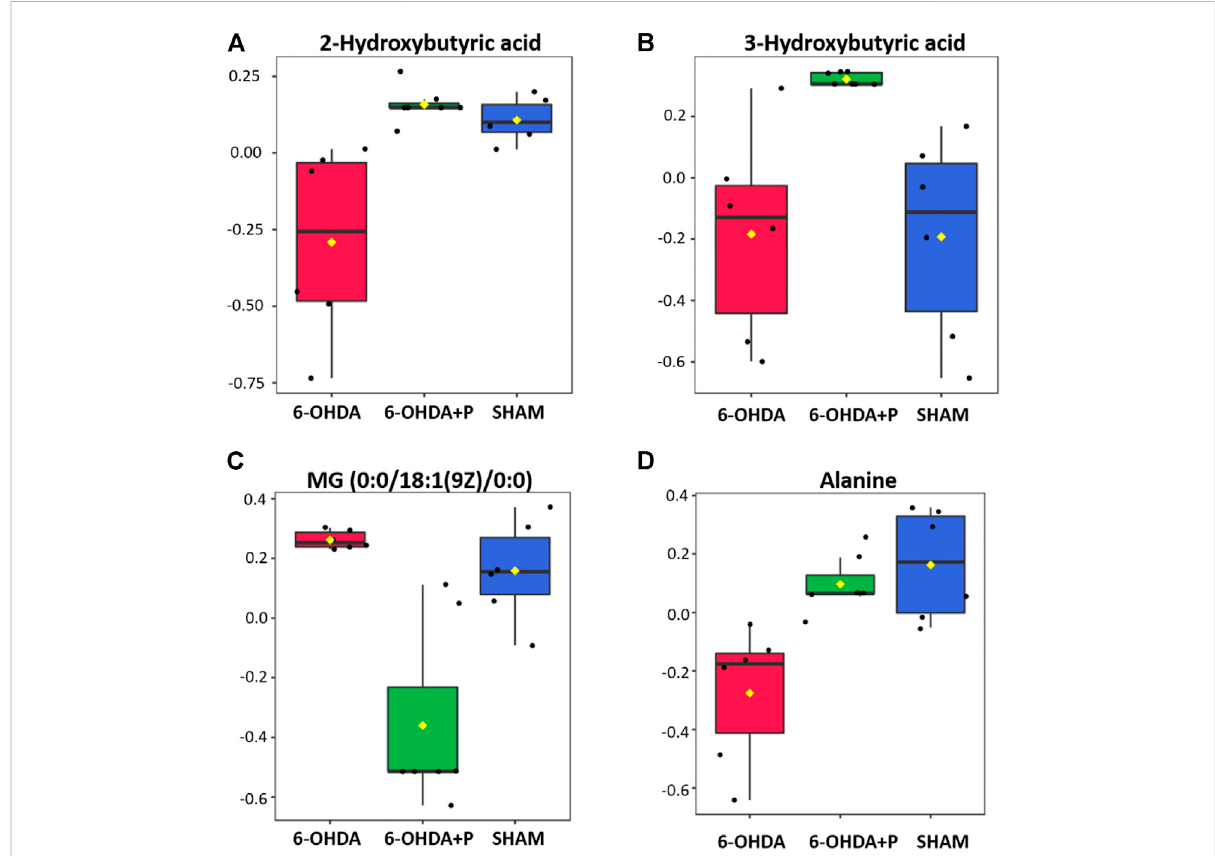
FIGURE 7 Statisticalanalysisofthefourmetaboliteswiththehighestestimatedamountsinthecomparisonbetweengroups. (A) Estimatedamountsofthe 2-hydroxubutyricacidmetaboliteinthe6-OHDA, 6-OHDA +PandShamgroups. (B) Estimatedamountsofthe3-hydroxubutyricacid metabolitein the6-OHDA,6-OHDA+PandShamgroups. (C) EstimatedamountsoftheMG(0:0/18:1(9Z)/0:0)metaboliteinthe6-OHDA,6-OHDA+PandSham groups. (D) Estimated amounts of the Alanine metabolite in the 6-OHDA, 6-OHDA + P and Sham